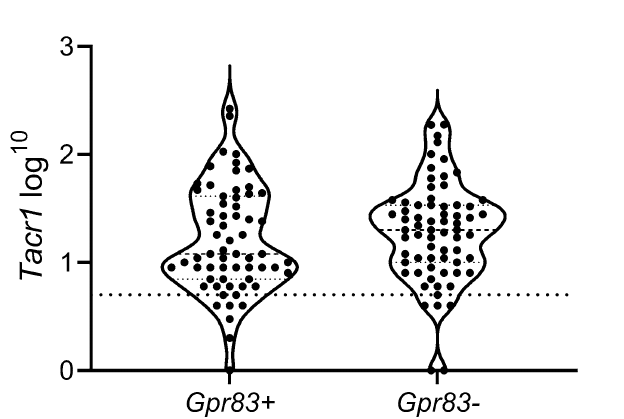
Figure 7. Violin plot of Tacr1 transcript number in Gpr83 -positive and Gpr83 -negative Phox2a neurons. The dotted line represents 5 transcripts per cell (i.e. the threshold for defining positivity). Lines within the violins represent the median and inter-quartile